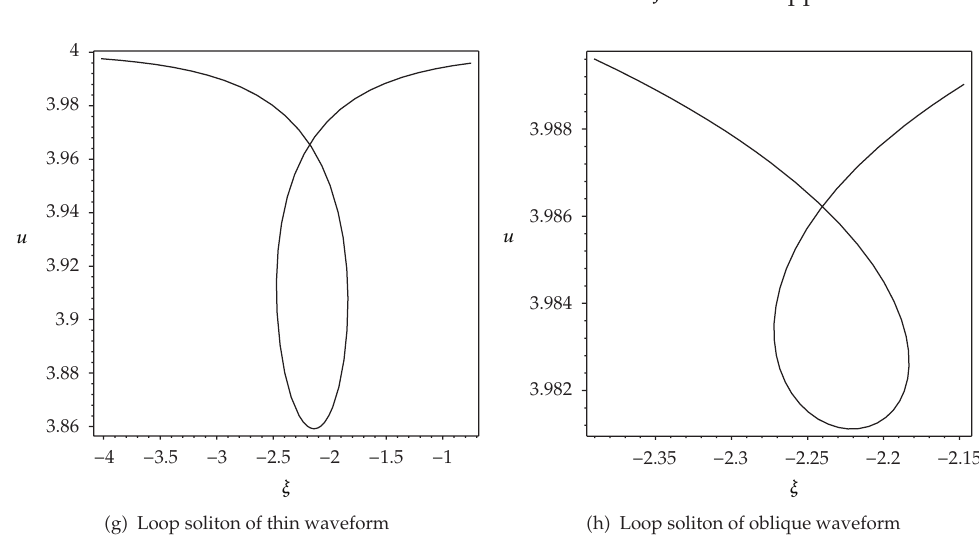
Figure 1: The profiles of multiwaveform of (cid:2) 3.6 (cid:3) for the given parameters and di ff erent ε -values: (cid:2) a (cid:3) ε (cid:7) 1 . 2; (cid:2) b (cid:3) ε (cid:7) 1 . 26; (cid:2) c (cid:3) ε (cid:7) 1 . 4; (cid:2) d (cid:3) ε (cid:7) 1 . 99; (cid:2) e (cid:3) ε (cid:7) 2; (cid:2) f (cid:3) ε (cid:7) 2 . 2; (cid:2) g (cid:3) ε (cid:7) 3; (cid:2) h (cid:3) ε (cid:7)